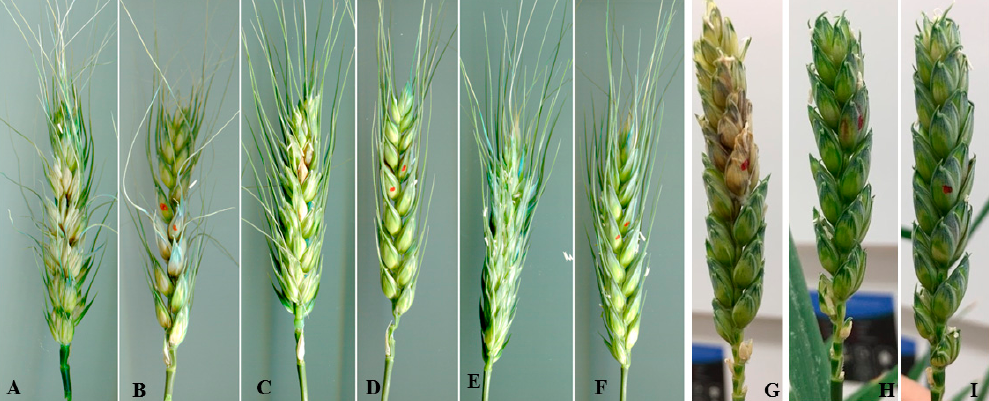
Figure 3. Photos showing typic symptoms of FHB on spikes of wheat genotype NIL-S ( A – F ) and Y1193-06 ( G – I ) one (in case of Y1193-06) or two weeks (in case of NIL-S) post inoculation with the F. graminearum isolate Fg-4-1 ( A , B,G ), Fg-4-2 ( C , D , H ), or water ( E , F , I ). Red spots indicate the inoc- ulated spikelets.